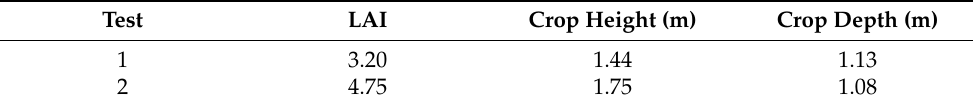
Table 1. Crop Characteristics.